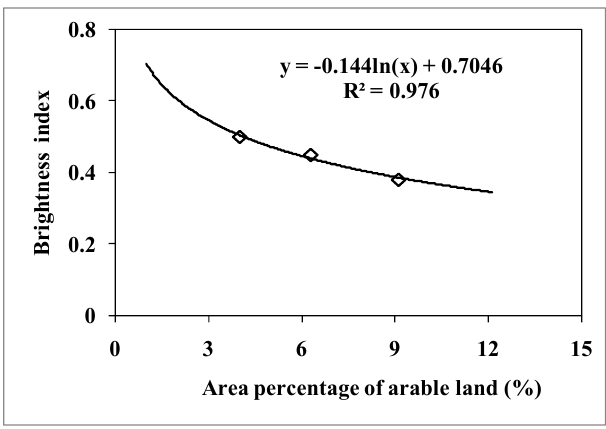
Figure 8. Brightness index versus area percentage of arable land.